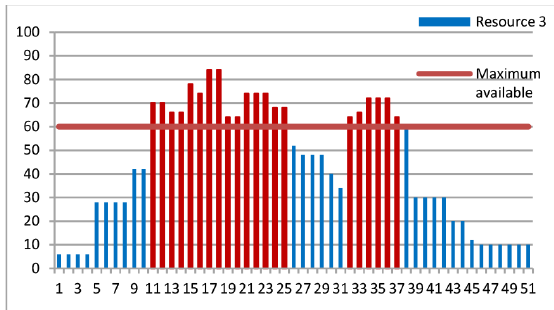
Figure 49. Daily usage of resource 2 throughout the calendar of the project (before using the method)-Experiment 3